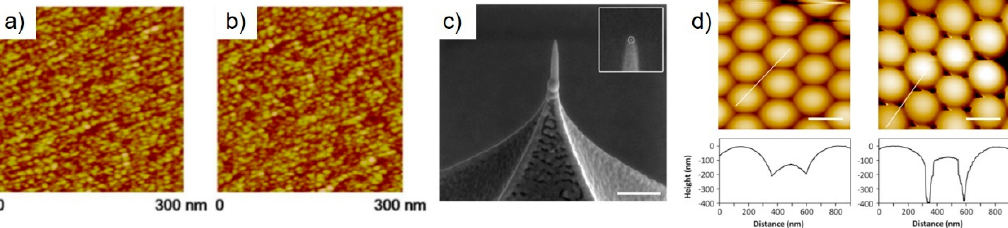
Figure 4. Atomic force microscopy (AFM) imaging with FEBID nano-pillars. ( a ) and ( b ) show tapping mode height images of SiN after 0.5 h and 7 h continuous operation, respectively, where the maintained image quality reflects the tip robustness. The Z-range is 3 nm in both high-resolution images. ( c ) shows a commercially available AFM tip, modified by a Pt–C nanopillar, revealing an end radius of ∼ 4 nm, as shown by a circle in the inset (scale bar is 200 nm). ( d ) shows a direct comparison of close-packed polystyrene spheres obtained with the aforementioned standard tip and the FEBID tip at the left and right, respectively (scale bar is 400 nm). Selected line scans along the white lines are shown below and clearly demonstrate the advantage of deeper profiling abilities via FEBID tips. ( a ) and ( b ) were adapted and reprinted from Chen et al., Nanotechnology 2006 [64], ( c ) and ( d ) were adapted and reprinted from Brown et al., Ultramicroscopy 2013 [28].